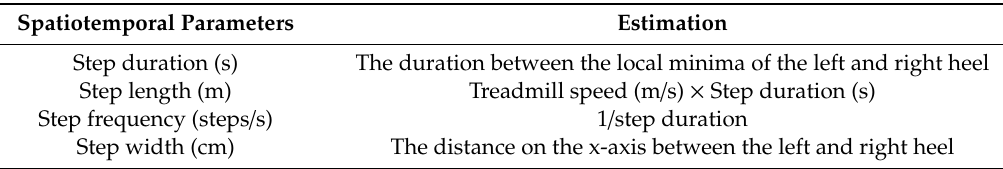
Table 1. Gait parameters and their method of estimation.